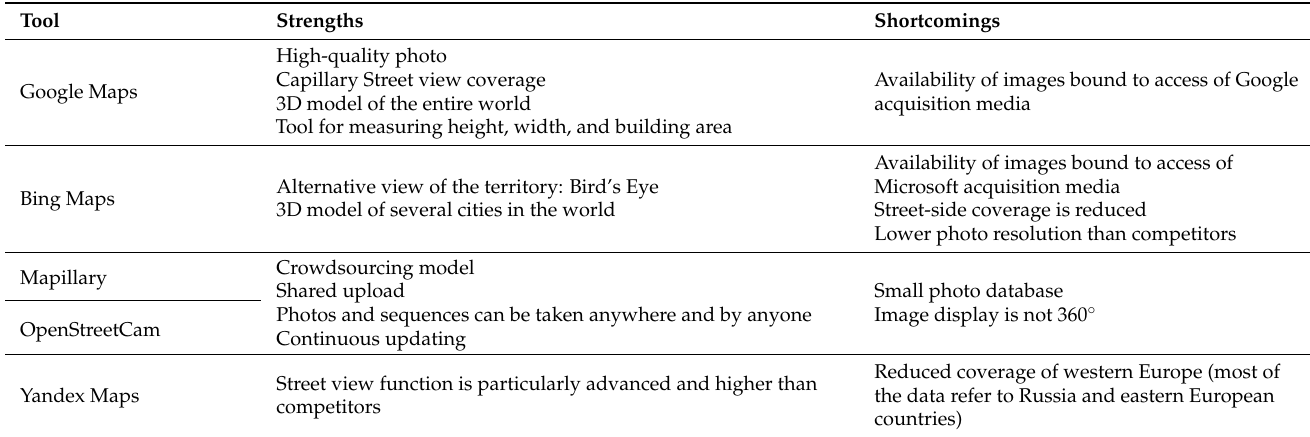
Table 2. Summary of strengths and shortcomings identified on each web-mapping